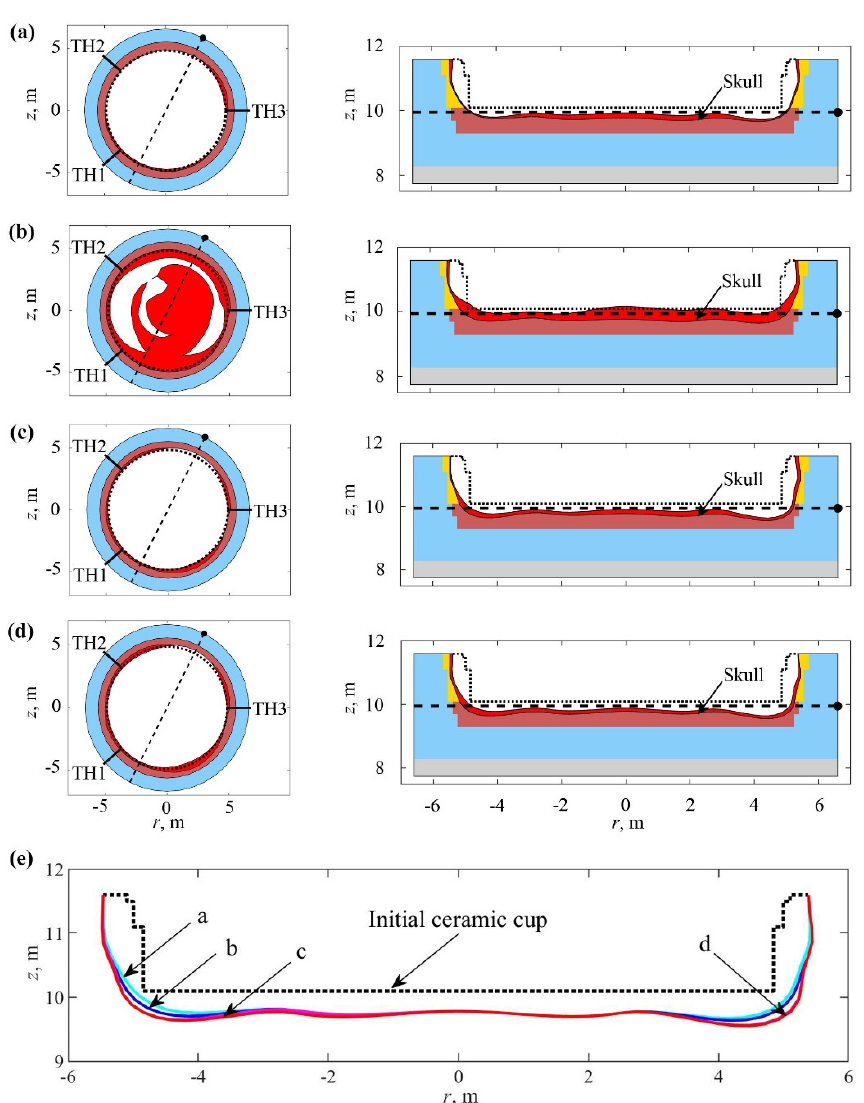
Figure 6. ( a – d ) Horizontal ( left column) and vertical ( right column) cross sections of the estimated hearth internal geometry for four selected dates corresponding to the major troughs labeled a, b, c, and d in Figure 5, respectively, ( e ) two-dimensional inner profiles of residual hearth refractories for four selected dates corresponding to the major troughs labeled a, b, c, and d in Figure 5.